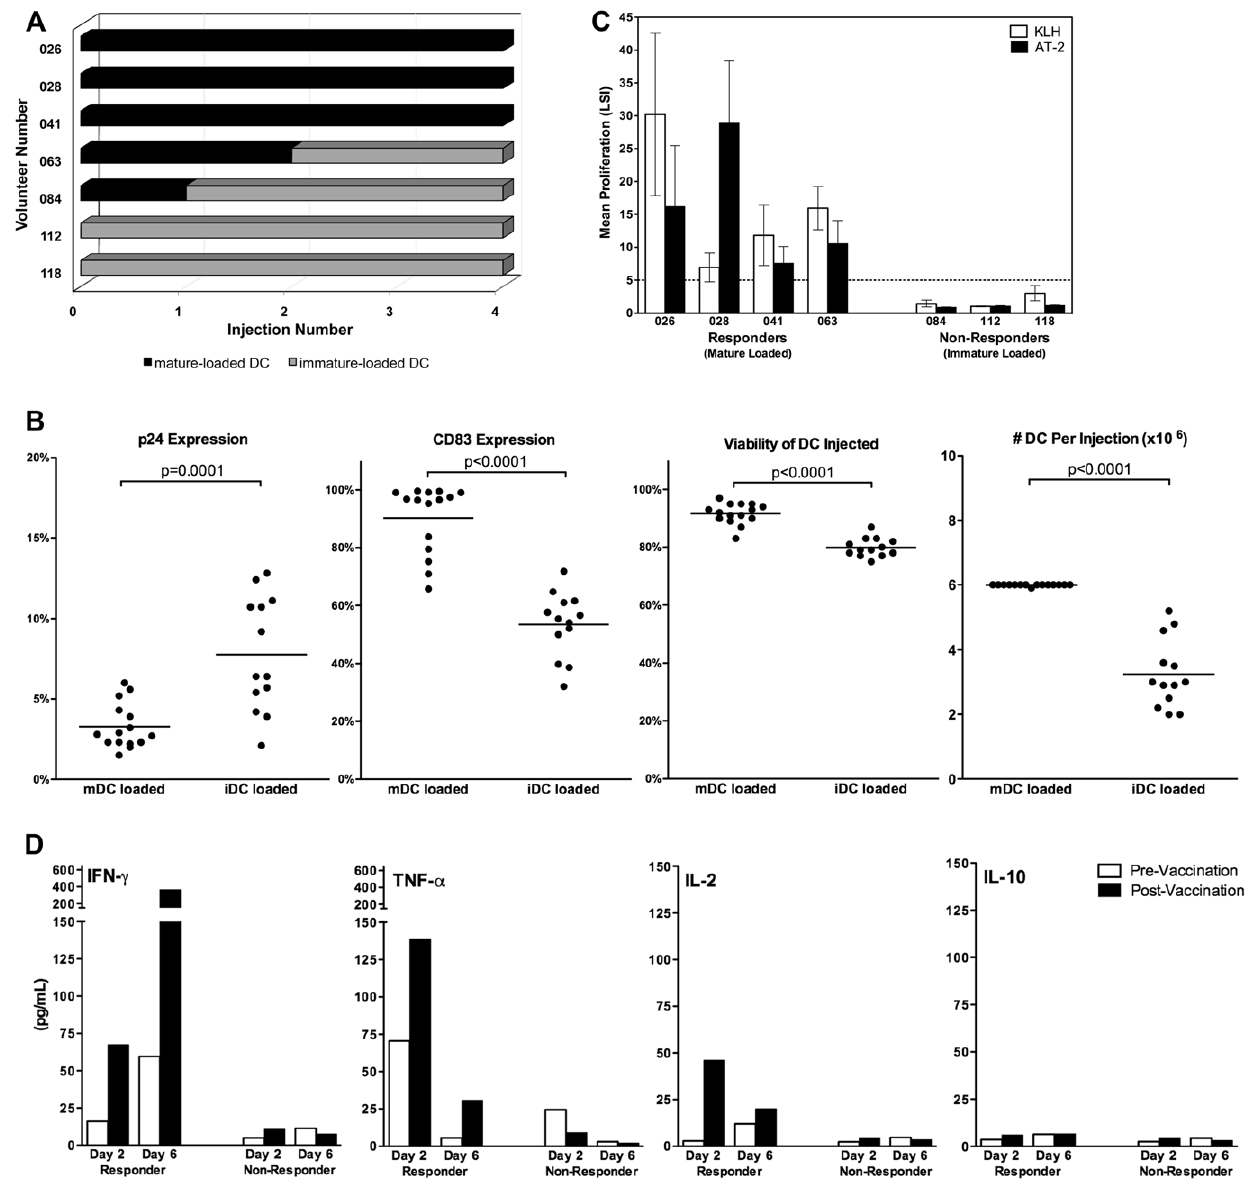
Figure 5. DC vaccine characterization. (A) Schematic representation of the DC maturation sequence. Autologous DC were loaded with vaccine either after maturation (black bars) or before maturation (grey bars). (B) Characteristics of vaccine-loaded DC, segregated by loading/maturation sequence. Expression of HIV-p24 and the maturation marker CD83 were assessed by flow cytometry. The number of DC per injection and cell viability at the time of injection were assessed by visual counts using Trypan Blue exclusion. P-values represent the statistical difference as determined by an unpaired t-test. (C) Proliferative responses of DC arm vaccinees to KLH (white bars) and AT-2 HIV (black bars). Data is shown as mean LSI 6 SEM from LPAs performed on fresh PBMC isolated between visits 1–16. (D) Cytokine secretion following AT-2 HIV stimulation of PBMC collected pre-vaccination (v.1, white bars) and two weeks following the final vaccination (v.11, black bars). IFN- c , TNF- a , IL-2 and IL-10 secretion from representative responder and non-responder vaccinees from the DC arm are shown.